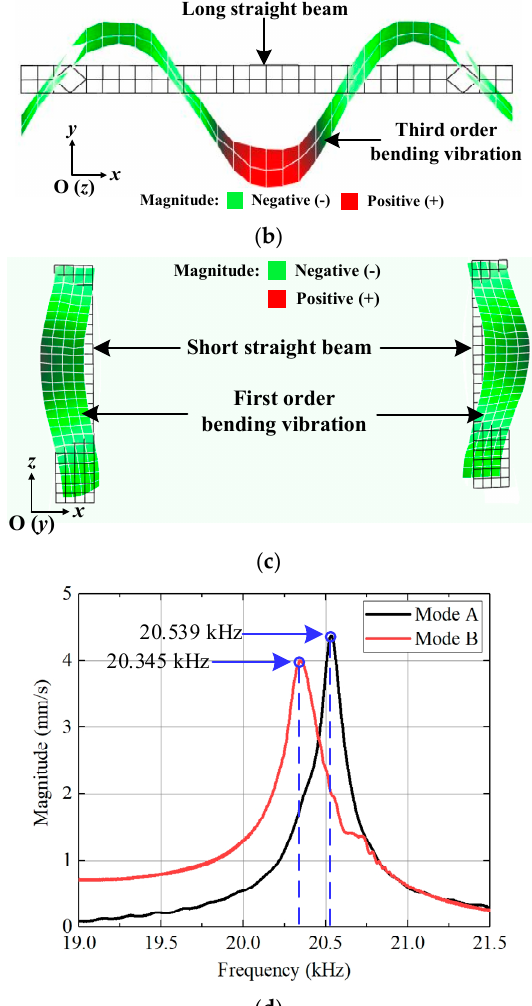
Figure 8. Vibration measurement results of the actuator prototype using the 3D Doppler laser vibrometer. ( a ) Mode A. ( b ) Mode B: the measured third order bending vibration shape presented in the long piezoelectric composite beams. ( c ) Mode B: the tested first order bending vibration exhibited in the short piezoelectric composite beams. ( d ) Amplitude-frequency curves.